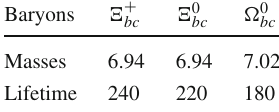
Table 1 Masses (in units of GeV) and lifetime (in units of fs) of the bottom-charmed baryons considered in